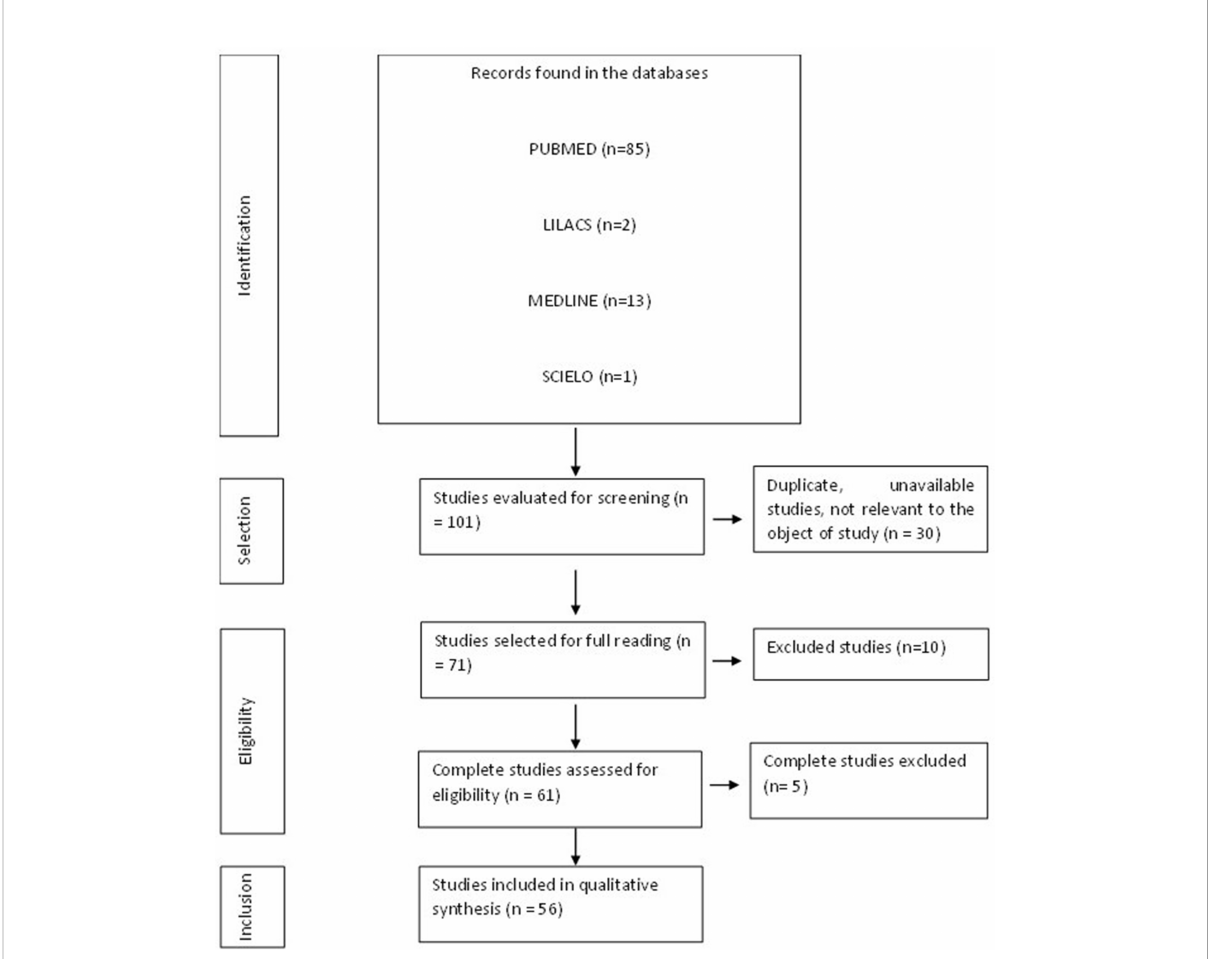
FIGURE 1 Flowchart of procedures for identi fi cation, selection, eligibility, and inclusion of studies for analysis. Bele ́ m, PA, Brazil,